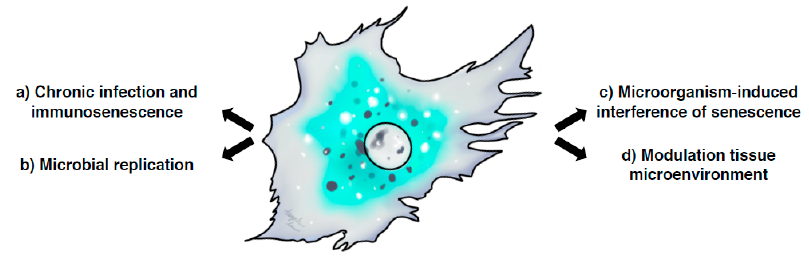
Figure 2. Crosstalk between cellular senescence and infections. Several aspects of senescence can be highlighted in infections: ( a ) immunosenescence due to chronic infections, which can impair the host immune responses and contribute to persistent infections; ( b ) the regulation of microbial replication and invasion where senescent cells can either enhance microbial replication or act as innate immune defence mechanisms limiting the rate of infection; ( c ) the microorganism-induced senescence, due to the direct induction of chronic DNA damage either indirectly via chronic inflammation and consequent oxidative stress, or directly by the production of genotoxins; ( d ) the senescence and modulation of the tissue microenvironment, which can contribute to the establishment of a favourable niche to ensure a successful